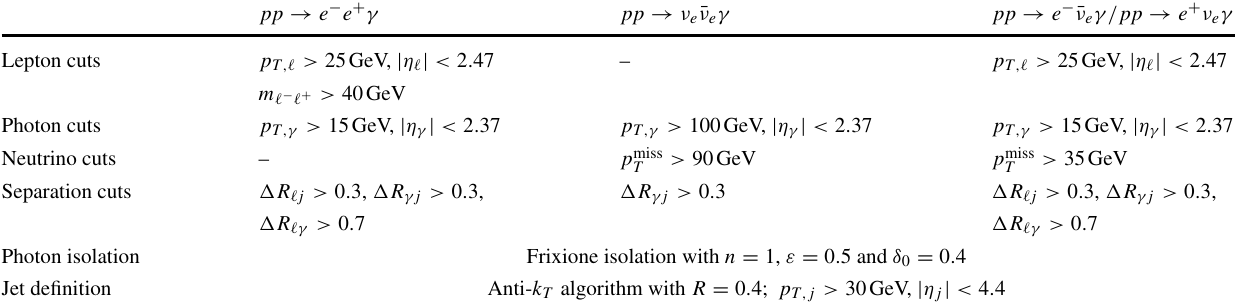
Table 7: The isolated photons are required to have a pseudo- rapidity | η γ | < 2 . 5, and the transverse momentum of the (sub)leading photon must fulfil p T ,γ > 40 ( 25 ) GeV. Further, werequire20 GeV < m γγ < 250 GeV fortheinvariantmass of the two photons. Our predictions show the importance of QCD corrections for this process: With K NLO = 4 . 61